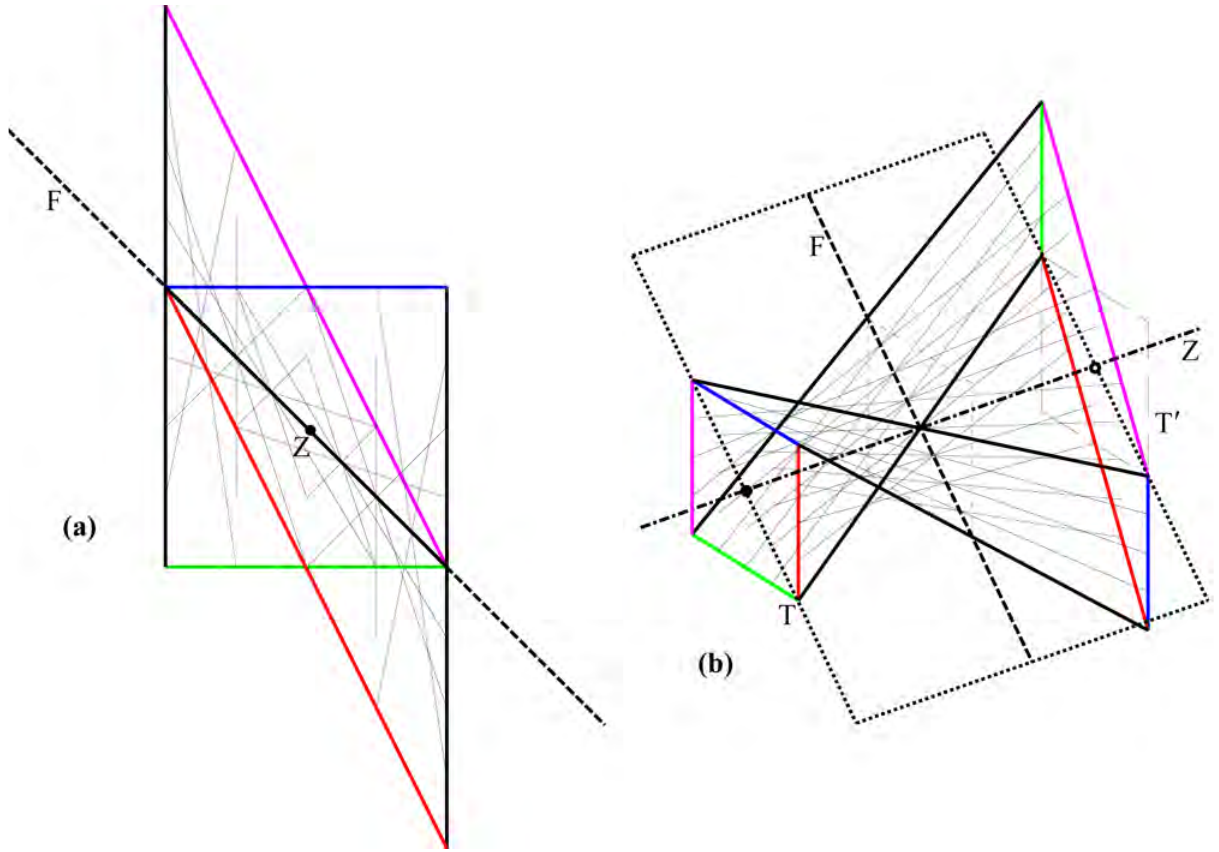
Figure 15 A pencil with divergency 2/2/ LJIM ++−= D at T. There is a single focal line. The focal planes of Figures 13 and 14 have merged into one. (b) azimuth °− 20 29 °− 20 , elevation 18 °− 20